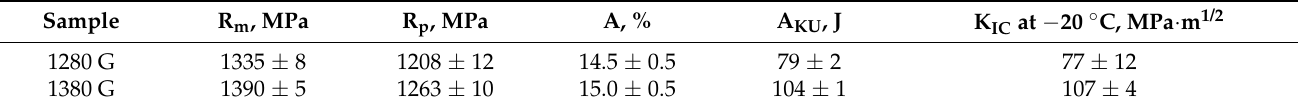
Table 3. Strength and toughness of the 1280 G and 1380 G rail